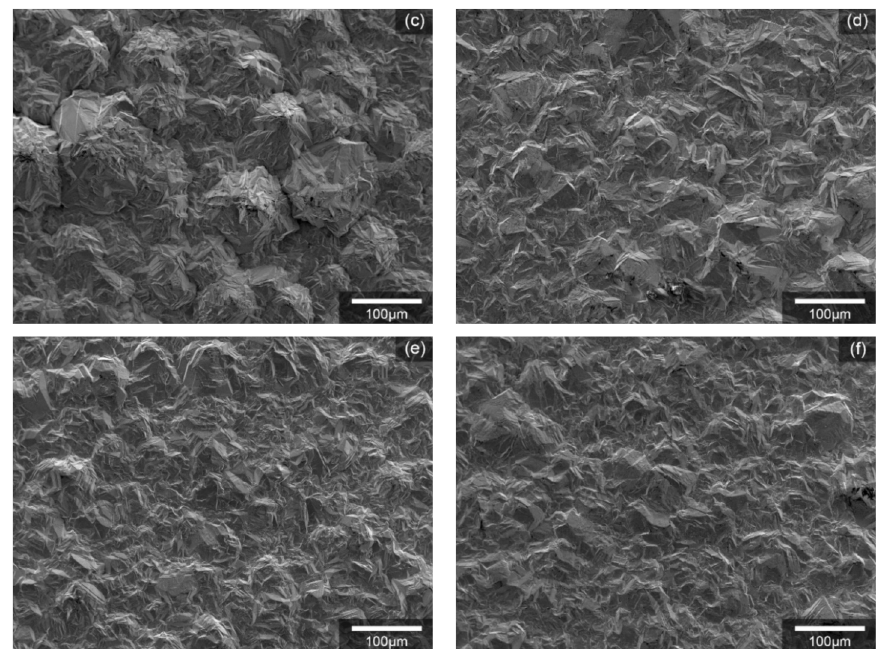
Figure 8. Surface morphology of cathode copper for different electrolyte circulation rates: ( a , b ) 0.5 L · min − 1 ; ( c , d ) 2.0 L · min − 1 ; ( e , f ) 4.0 L · min − 1 . The position of the single-side jet inlet was